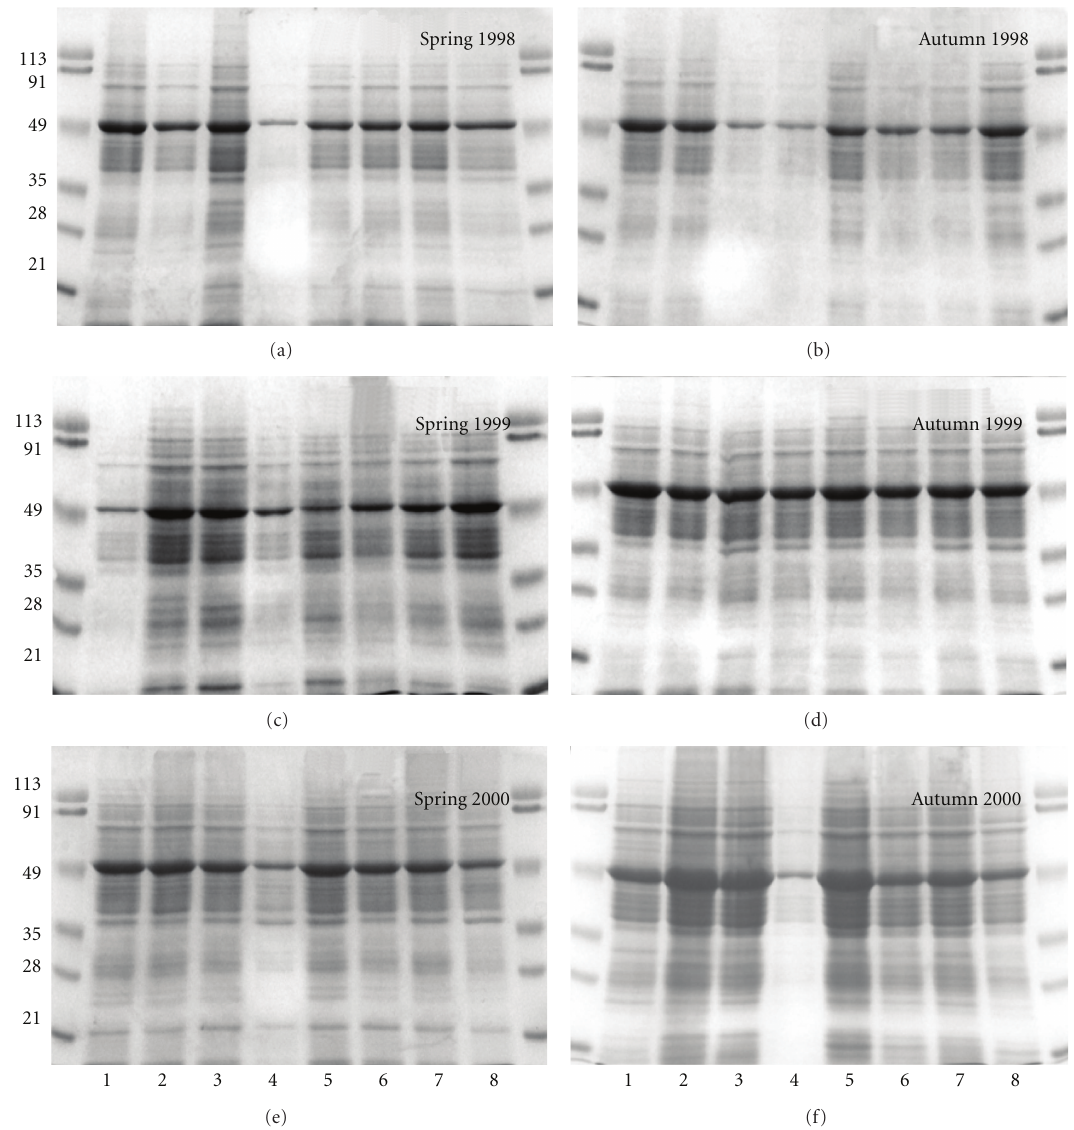
Figure 9: Soluble protein profiles: KDa (kilo Dalton), molecular weights of standards. Running numbers denote the ecotypes at their transplantation sites as follows: 1 = K / Kan, 2 = K / Oul, 3 = K / Kuu, 4 = K / NAR, 5 = R / Kuu, 6 = R / Nar, 7 = R / Pal, and 8 = R / Kil (see text for more